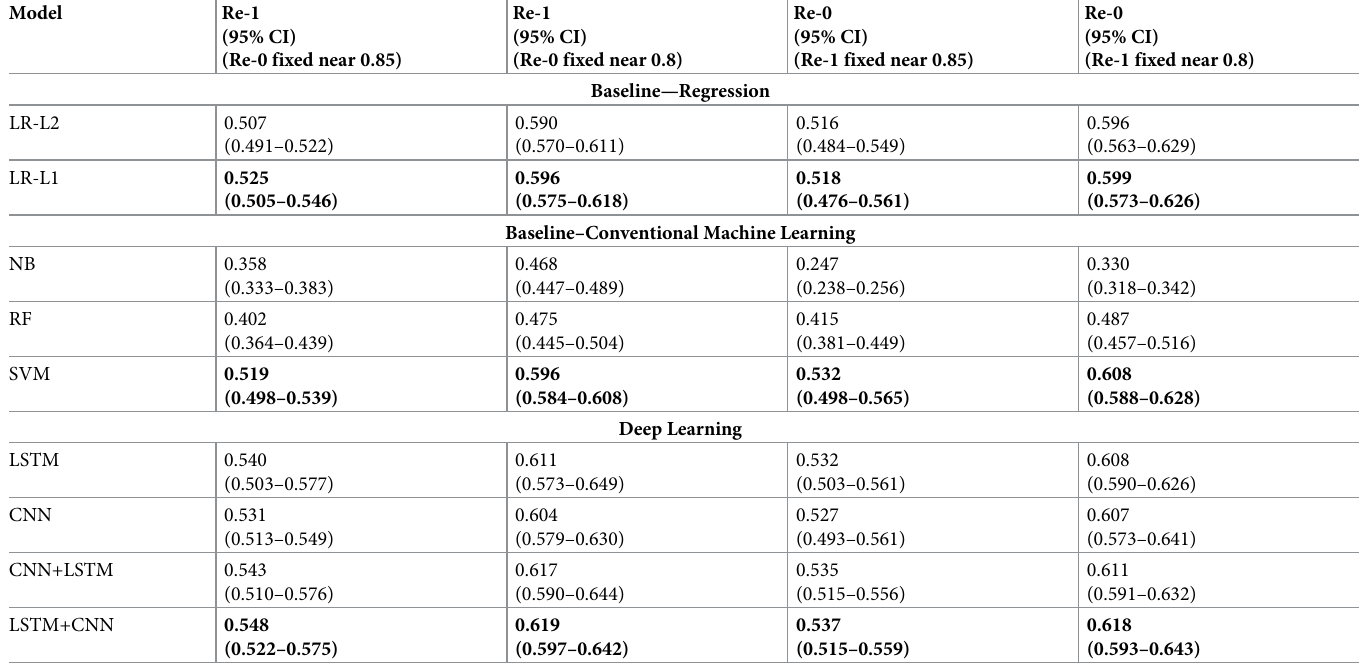
Table 4. Performance comparison of machine learning models at high-sensitivity and high-specificity operating points. Model Re-1 (95% CI) (Re-0 fixed near